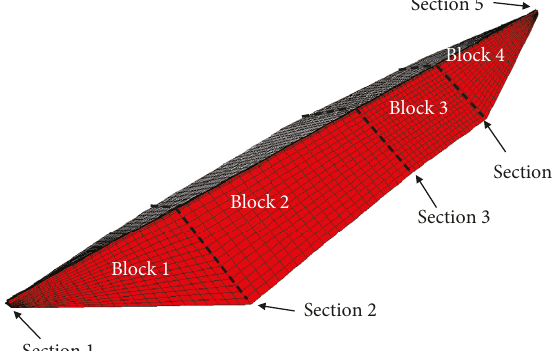
Figure 8: View of the section and blocks in the 3D finite difference